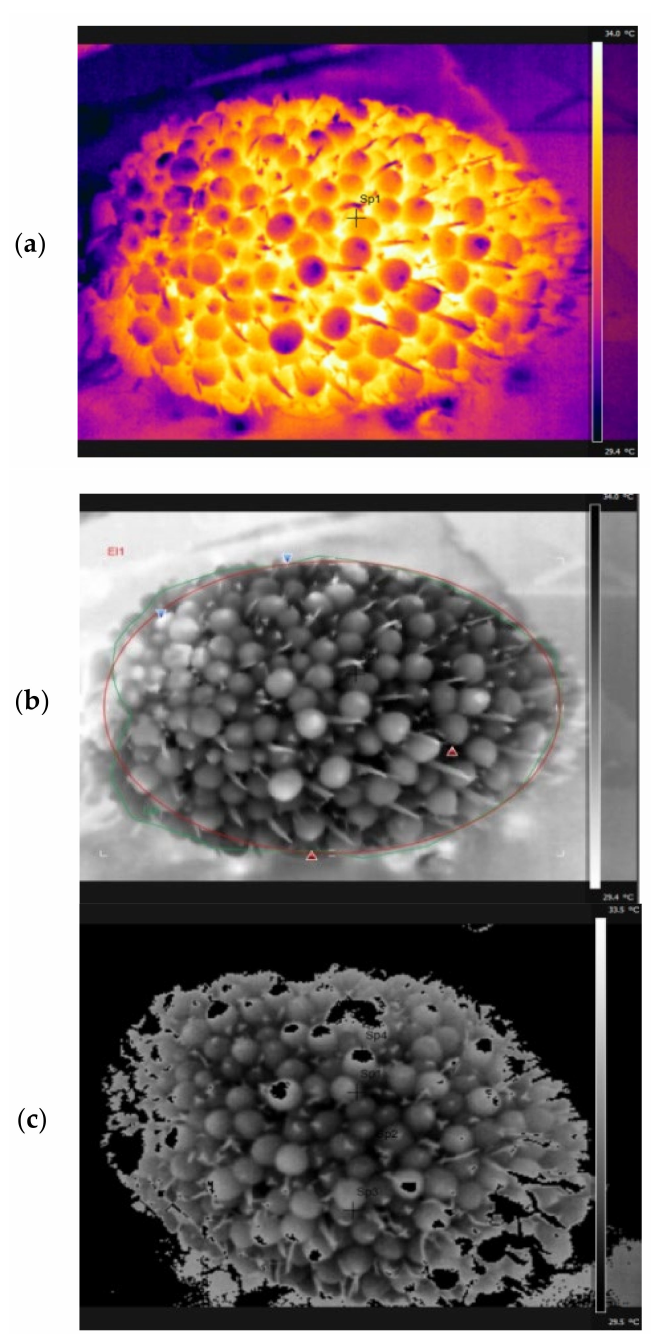
Figure 6. Thresholding segmentation for ROI of an oil palm FFB sample: ( a ) main thermal image, ( b ) gray scale image, and ( c ) segmented